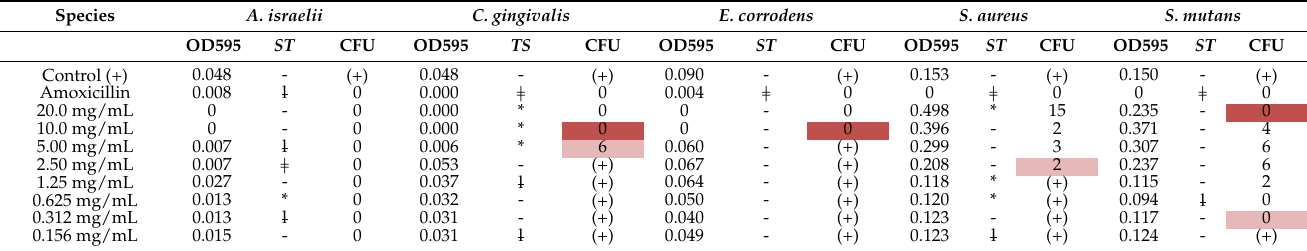
Table 2. Microbial susceptibility of biofilm former species under